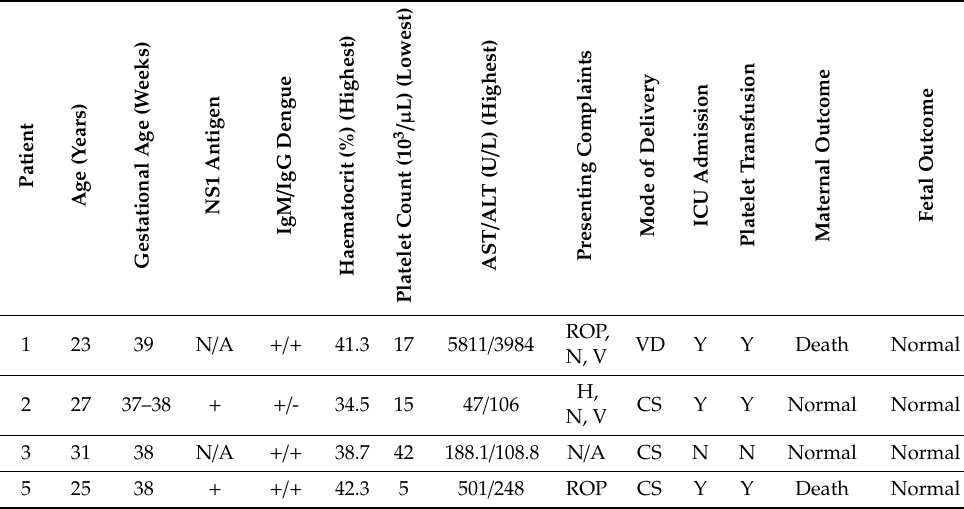
Table 5. Summary of case